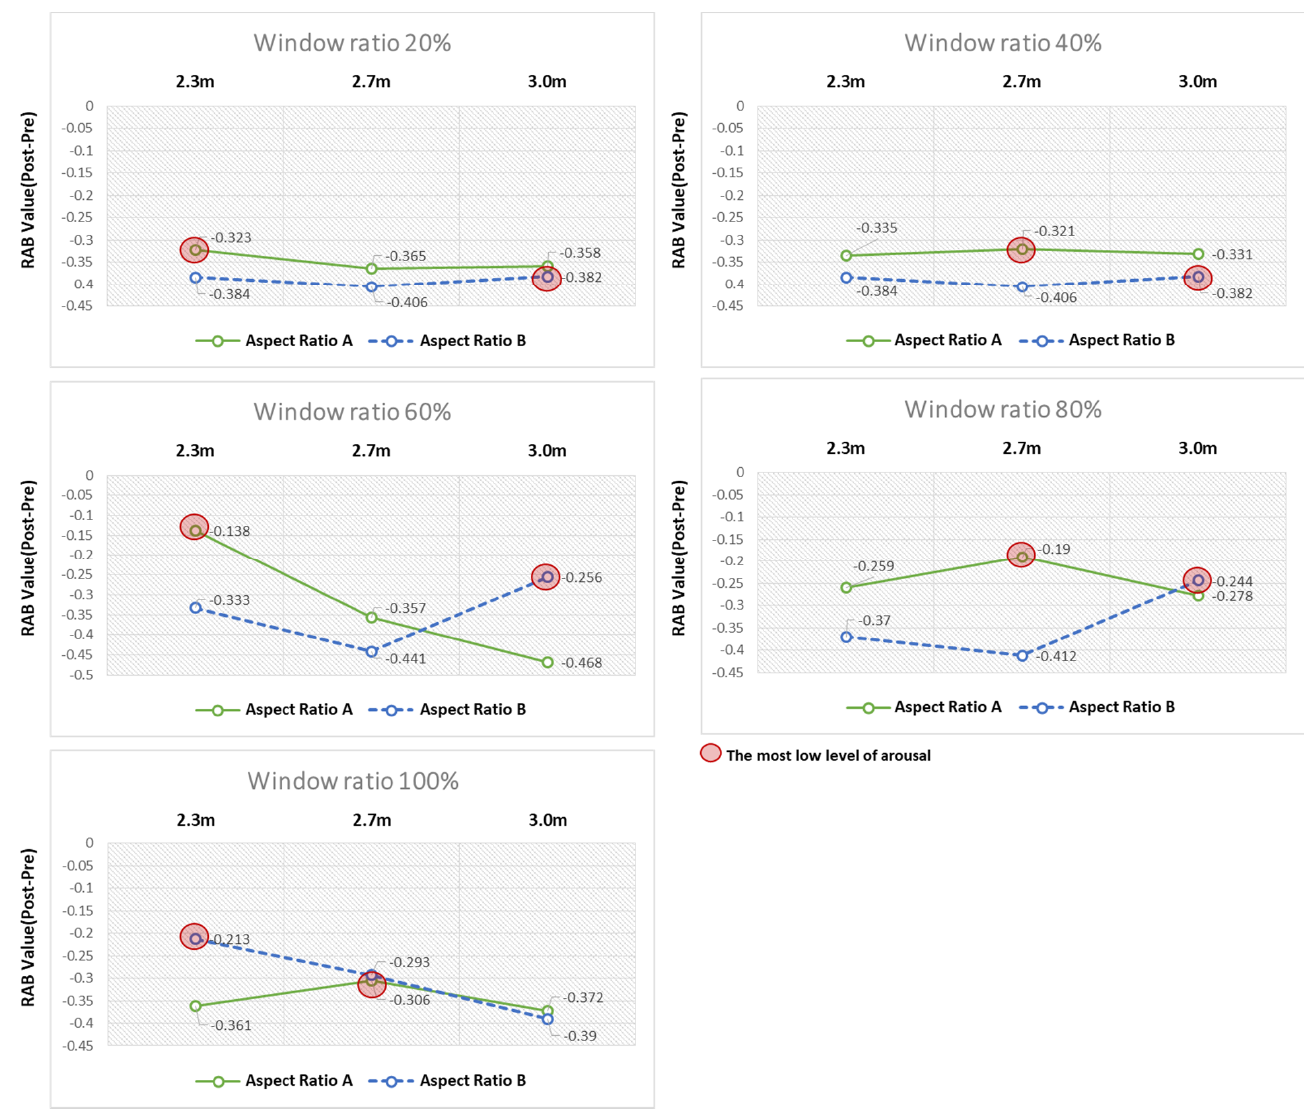
Figure 12. Analysis of arousal levels based on window ratio. As a result of the comparison between elements of ceiling height, the element with the smallest level of awakening was marked with a red circle. Table 4. Analysis of the difference in RAB indicator values between ceiling height and aspect ratio (A/B).